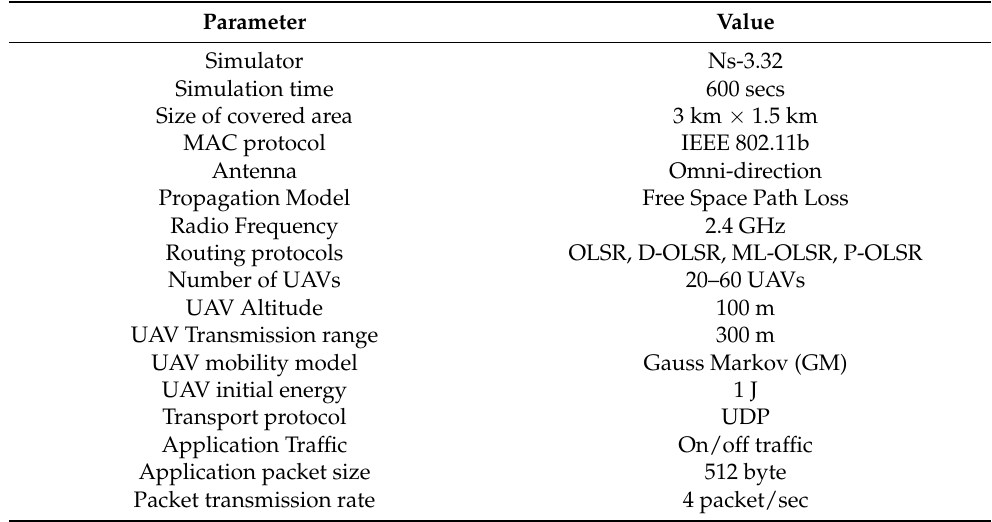
Table 3. UAV parameter configuration for simulation.